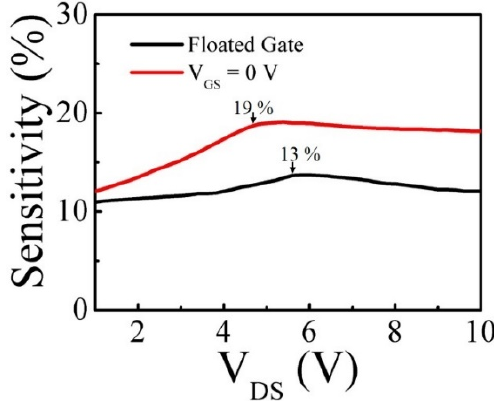
− I air for each case. 2